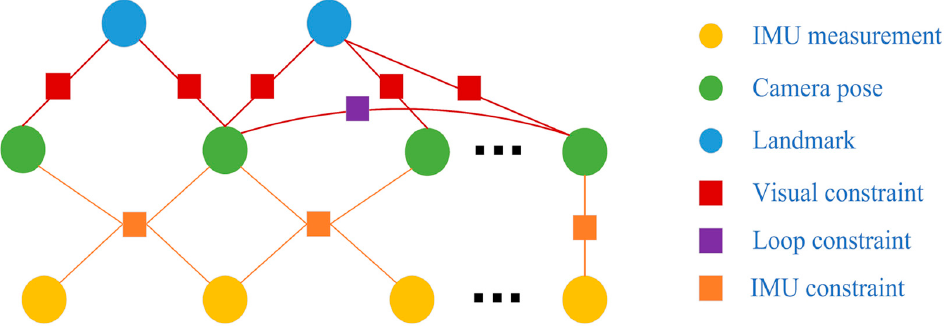
Figure 4. Factor graphs of our system.